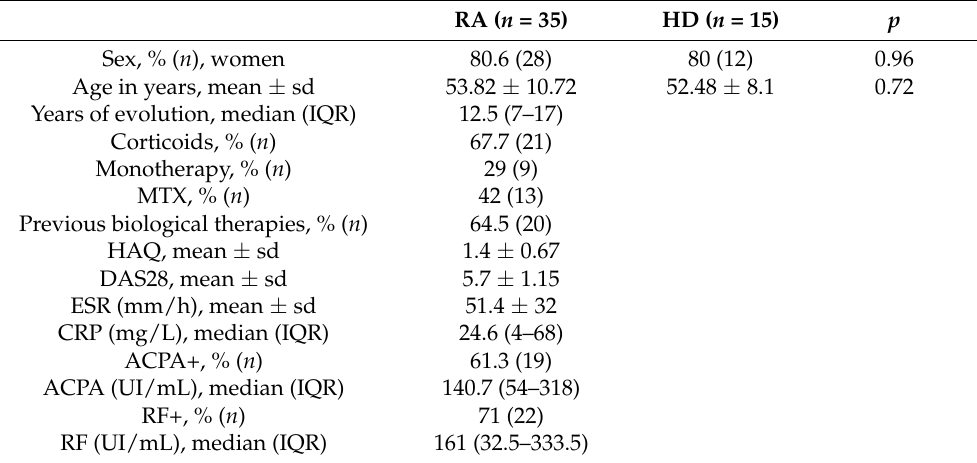
Table 1. Demographic, clinical, and laboratory characteristic data of study